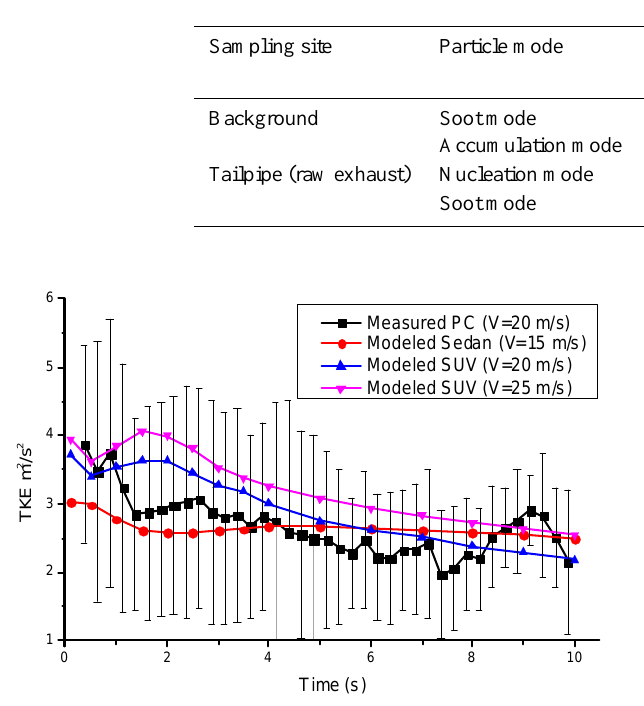
Figure 2. Comparison of the on-road TKE from the passenger ve- Fig. 2. Comparison of the on-road TKE from the passenger vehicle chasing experiments 3 hicle chasing experiments of the FEVER project (black line) and model simulations (red, blue, and purple lines). The error bars rep- of the FEVER project (black line) and model simulations (red, blue and purple lines). The 4 resent the 25th and 75th percentiles of the measured on-road TKE. PC stands for passenger vehicle and SUV stands for sport utility error bars represent the 25 th and 75 th percentiles of the measured on-road TKE. PC stands 5 vehicle. V is the average traveling speed (ms − 1 ) of PC in chasing experiments or the vehicle speed used in model for passenger vehicle and SUV stands for sport utility vehicle. V is the average travelling 6 speed (m/s) of PC in chasing experiments or the vehicle speed used in model simulation. 7